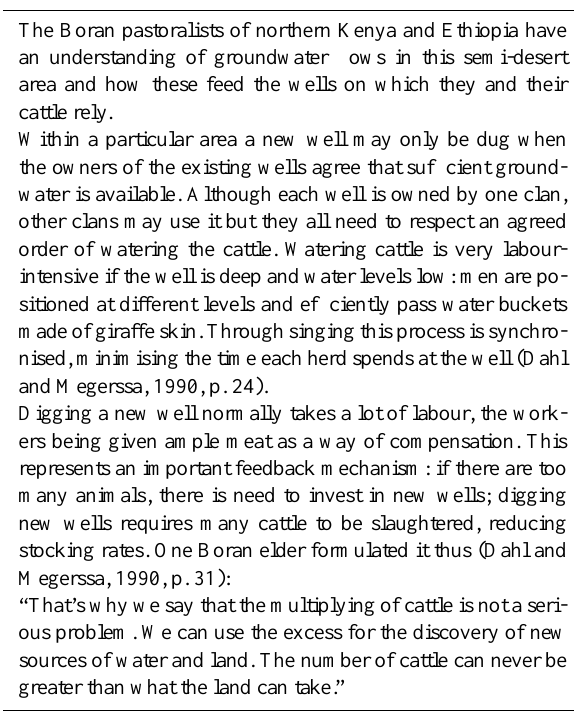
Table 1. Boran hydrogeology and water management (source: adopted from Dahl and Megerssa, 1990). The Boran pastoralists of northern Kenya and Ethiopia